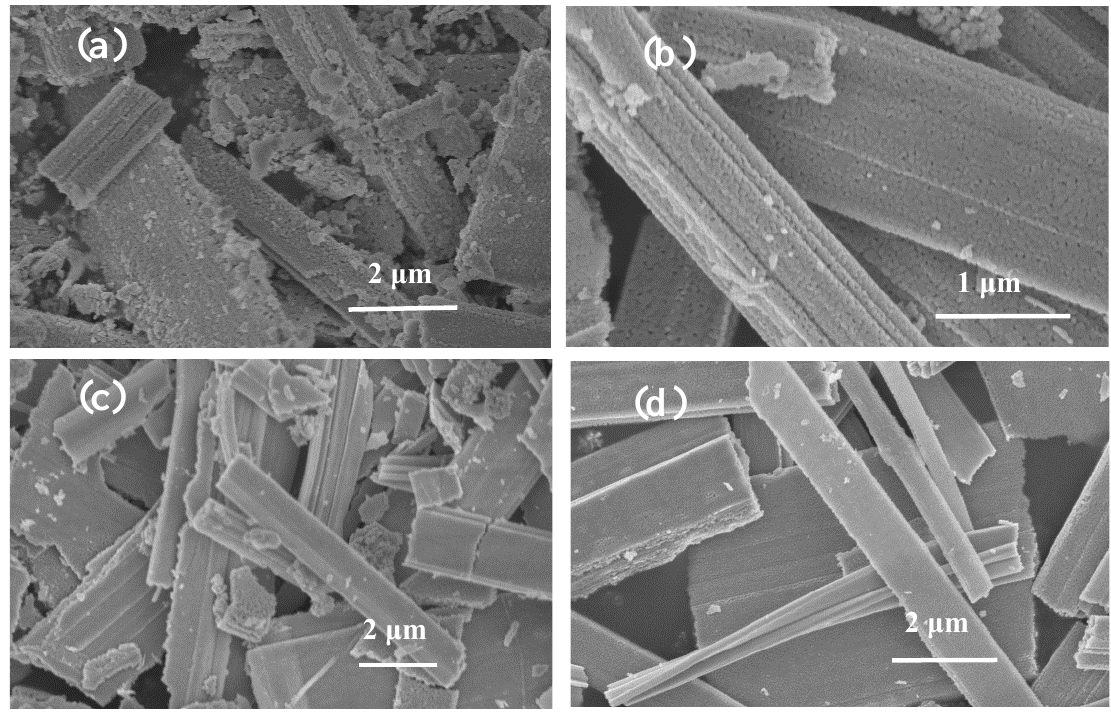
Figure 3. SEM images of ( a ) 1 wt% Ru/Ta 3 N 5 NBs, ( b ) 3 wt% Ru/Ta 3 N 5 NBs, ( c ) 7 wt% Ru/Ta 3 N 5 NBs, and ( d ) 10 wt% Ru/Ta 3 N 5 NBs.